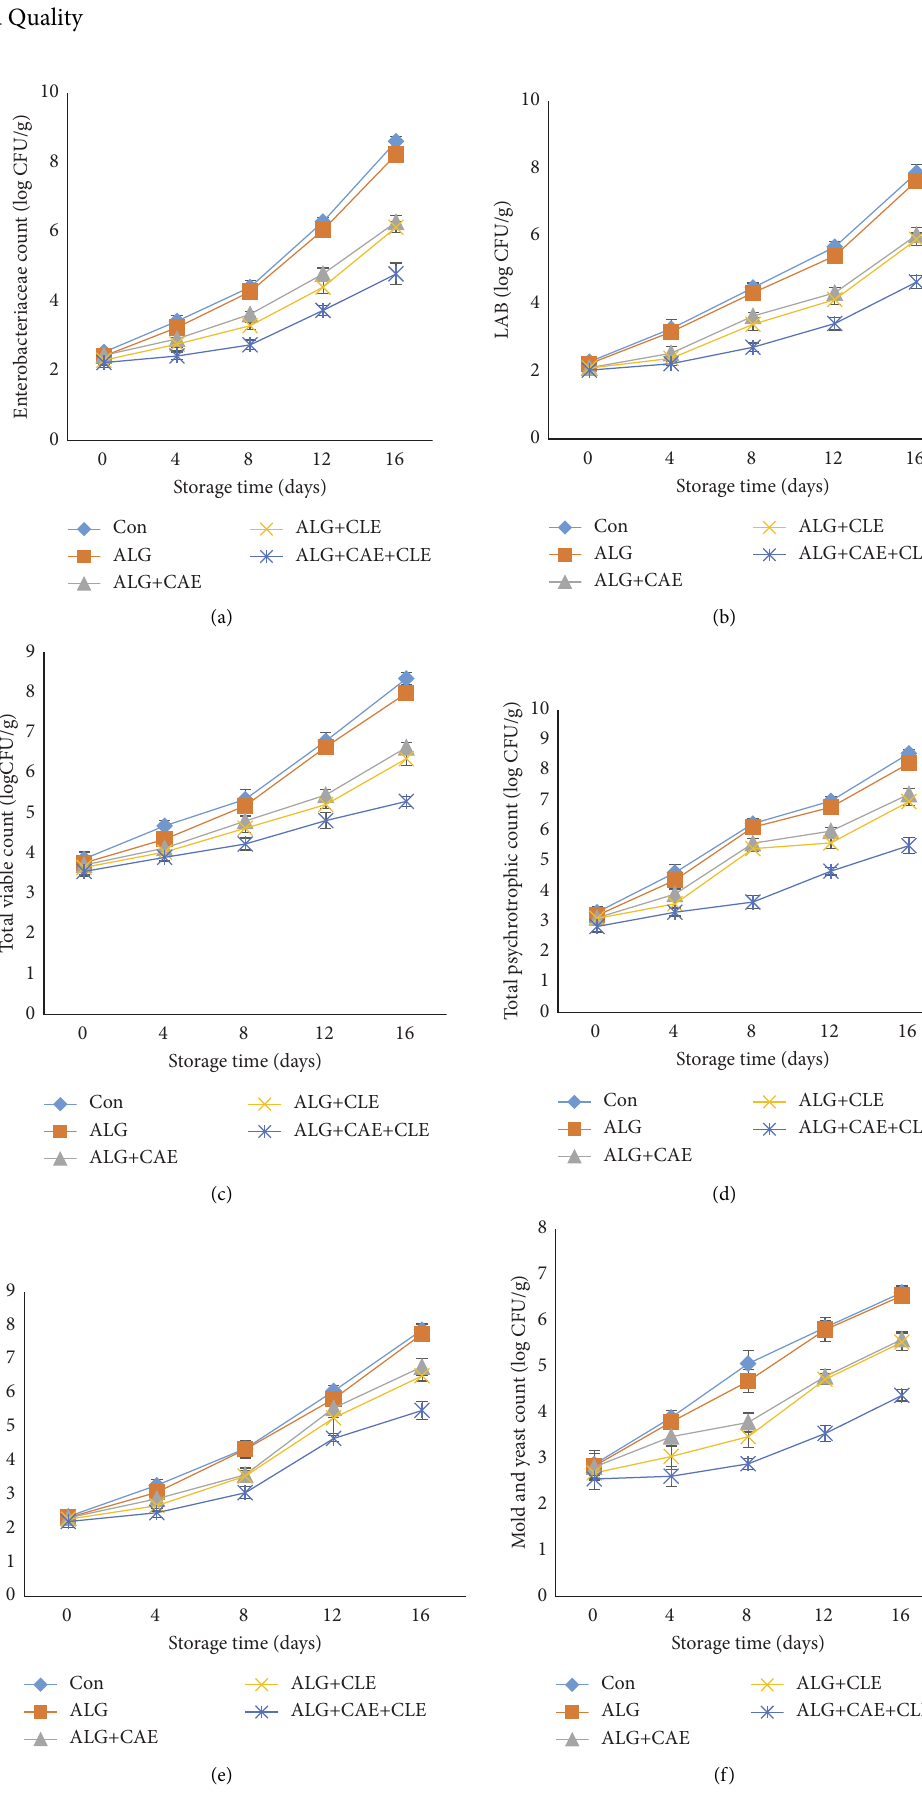
Figure 2: Changes in microbial counts of chicken fllet samples during refrigerated